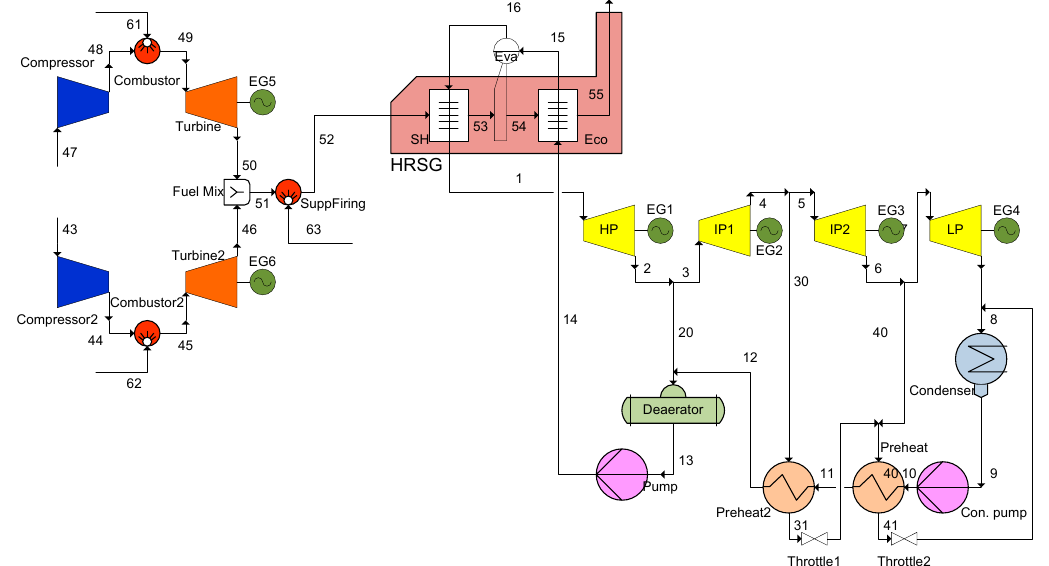
Figure 3. Natural gas fired CC plant with two gas turbines and with or without supplementary firing.